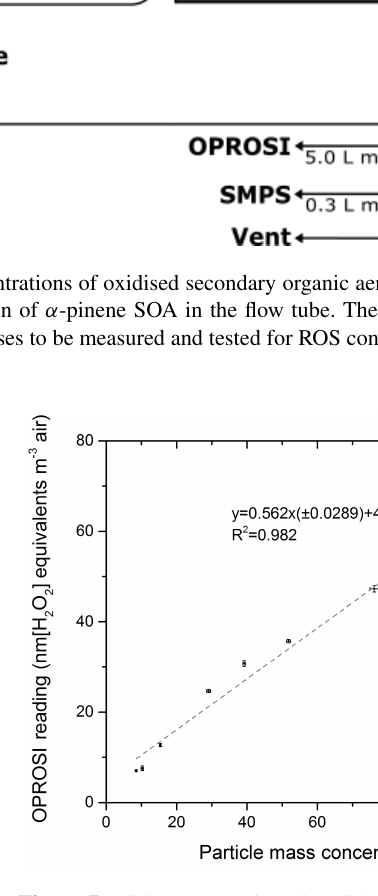
Figure 7. ROS concentration (OPROSI) compared with mass con- centration of α -pinene SOA particles (SMPS). Increased mass con- centration of oxidised SOA was found to correlate with increased ROS